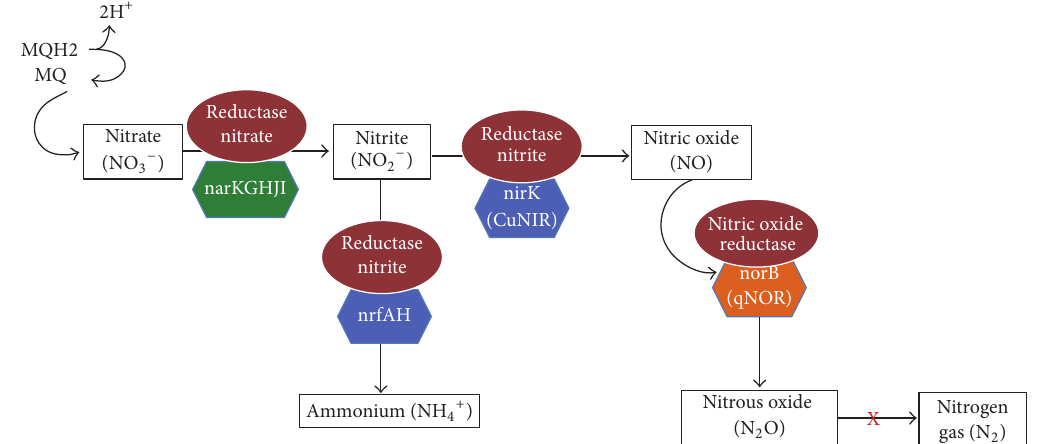
Figure 3: Model building of nitrate reductase from C. pseudotuberculosis biovar Equi. Showed here is respiratory nitrate reduction to nitrite; incomplete denitrification of nitrite in which nitrous oxide is the final product; and Nrf-dependent